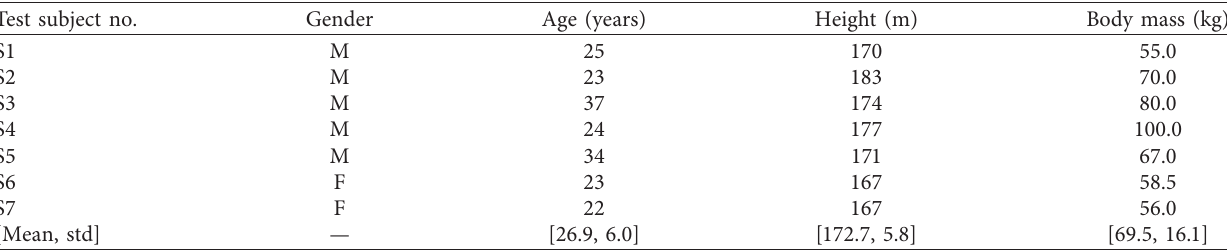
Figure 10: First ten simulated modes of the footbridge. (a) 1st vertical bending (main span), 0.95Hz. (b) 1st lateral bending +torsion (main span), 0.97Hz. (c) 2nd vertical bending (main span), 1.09Hz. (d) 3rd vertical bending (main span)+1st vertical bending (side span)+lateral (column), 1.65Hz. (e) 3rd vertical bending (main span)+1st vertical bending (side span), 1.71 Hz. (f) 1st torsion (main span), 2.20 Hz. (g) 4th vertical bending (main span), 2.27Hz. (h) 5th vertical bending (main span), 2.89Hz. (i) 2nd lateral bending +torsion (main span), 3.15Hz. (j) 6th vertical bending (main span), Table 5: Basic information of the test subject.